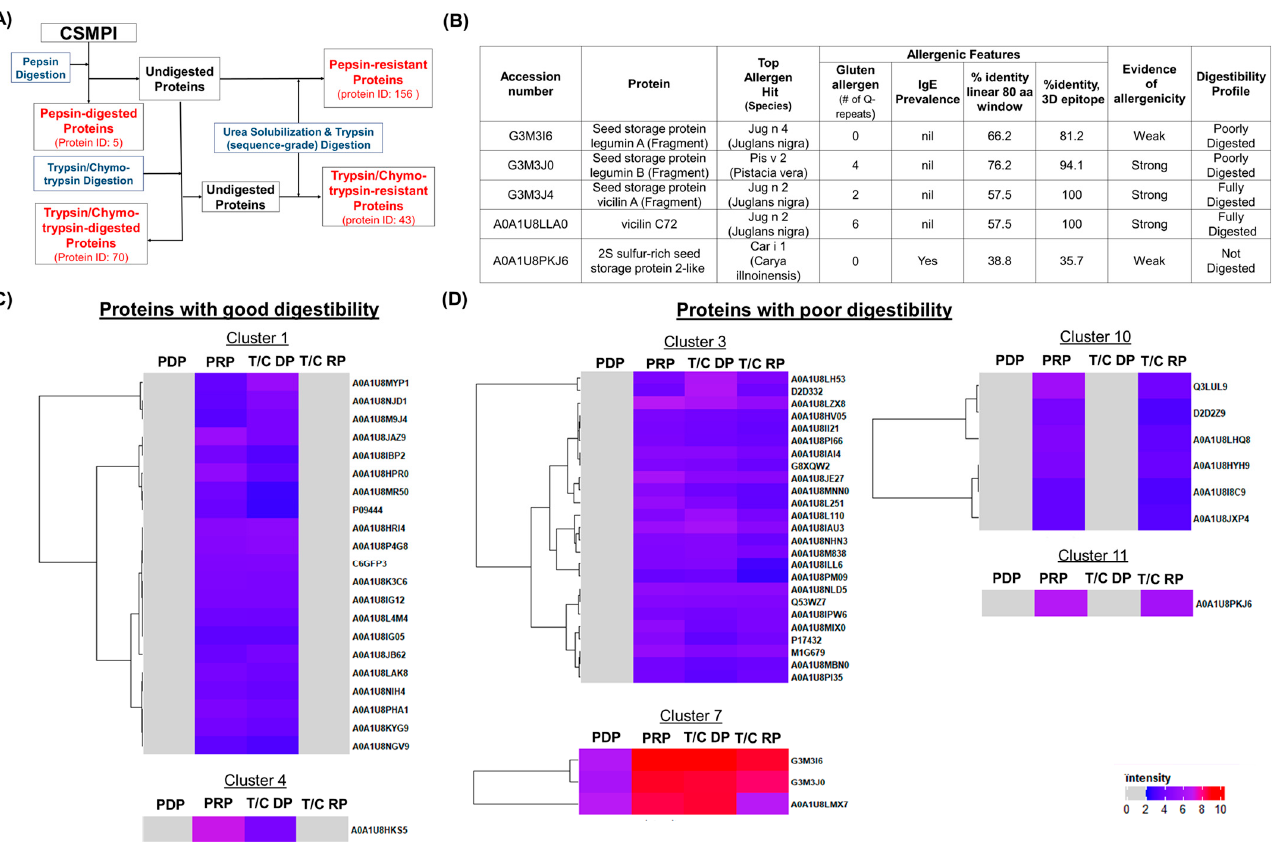
Figure 5. The digestibility and allergenic profile of CSMPI. ( A ) Schematic workflow of the in vitro digestibility assay with 4 protein fractions (highlighted with red text) collected for LC-MS/MS analysis. ( B ) The allergenic profile of the top 5 most abundant CSM proteins. ( C ) CSM proteins with a good digestibility profile. ( D ) CSM proteins with a poor digestibility profile. PDP: pepsin-digested protein; PRP: pepsin-resistant protein; T/C DP: trypsin/chymotrypsin-digested protein; T/C RP: trypsin/chymotrypsin-resistant protein .